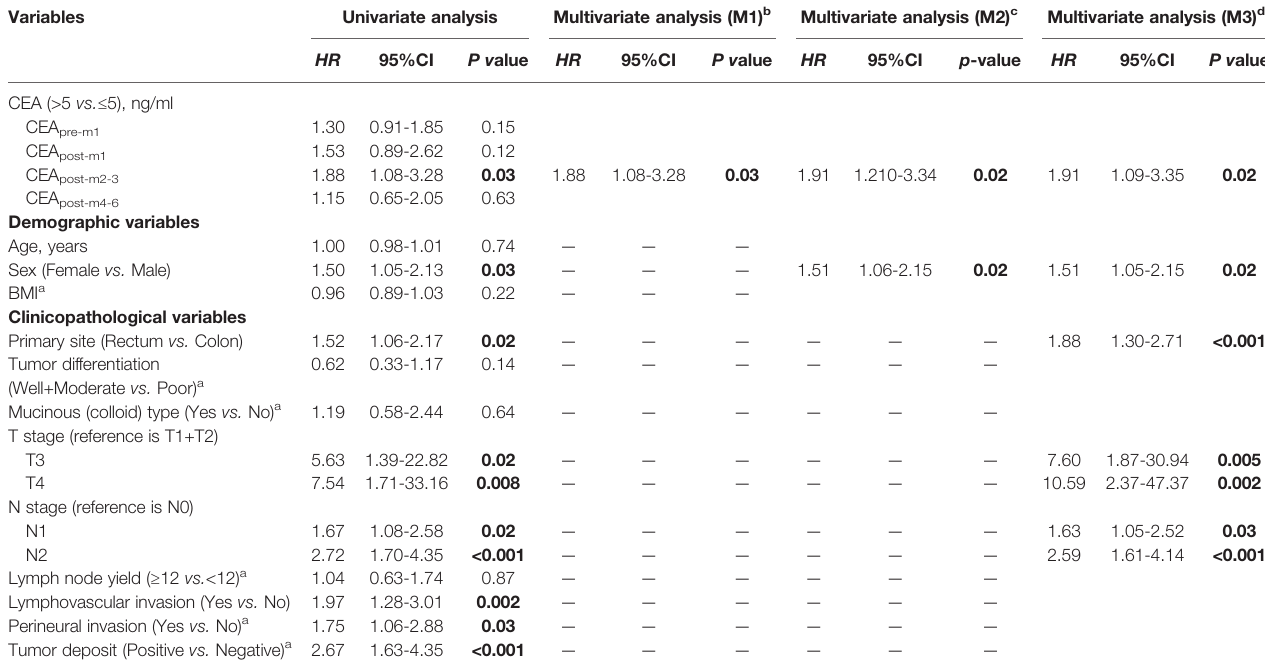
TABLE 2 | Univariate and Multivariate Analysis of 3-year Recurrence Free Survival based on Primary Analysis Population. Variables